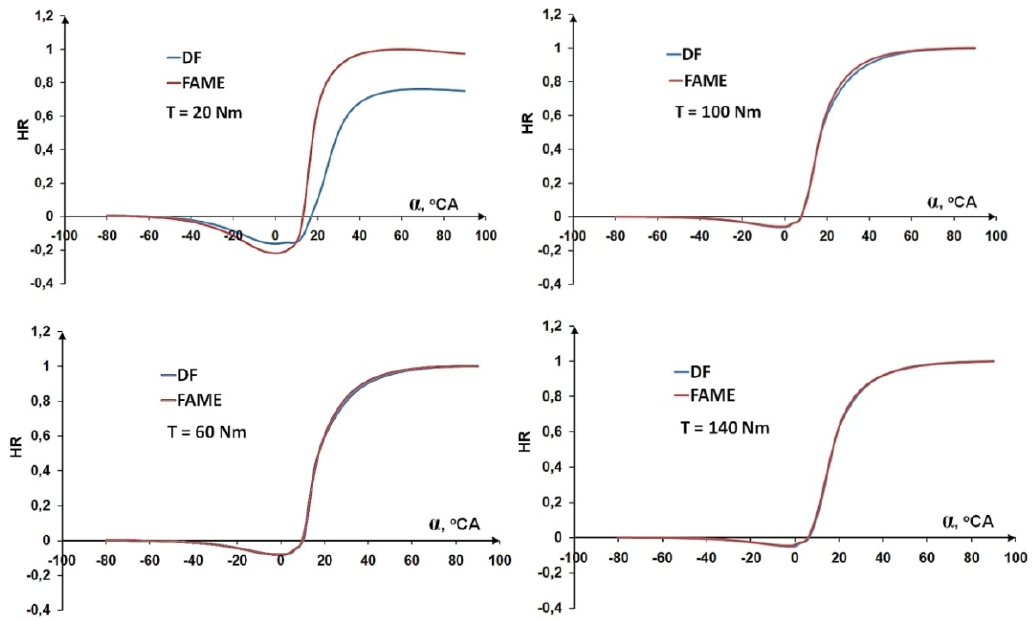
Figure 6: Characteristics of the relative amount of heat released during the combustion process in the cylinder of the Fiat 1.3 MultiJet engine supplied with the following fuels: FAME, DF, operating according to the load characteristics for n = 1750 rpm, with loads T = 20, 60, 100 and 140 Nm